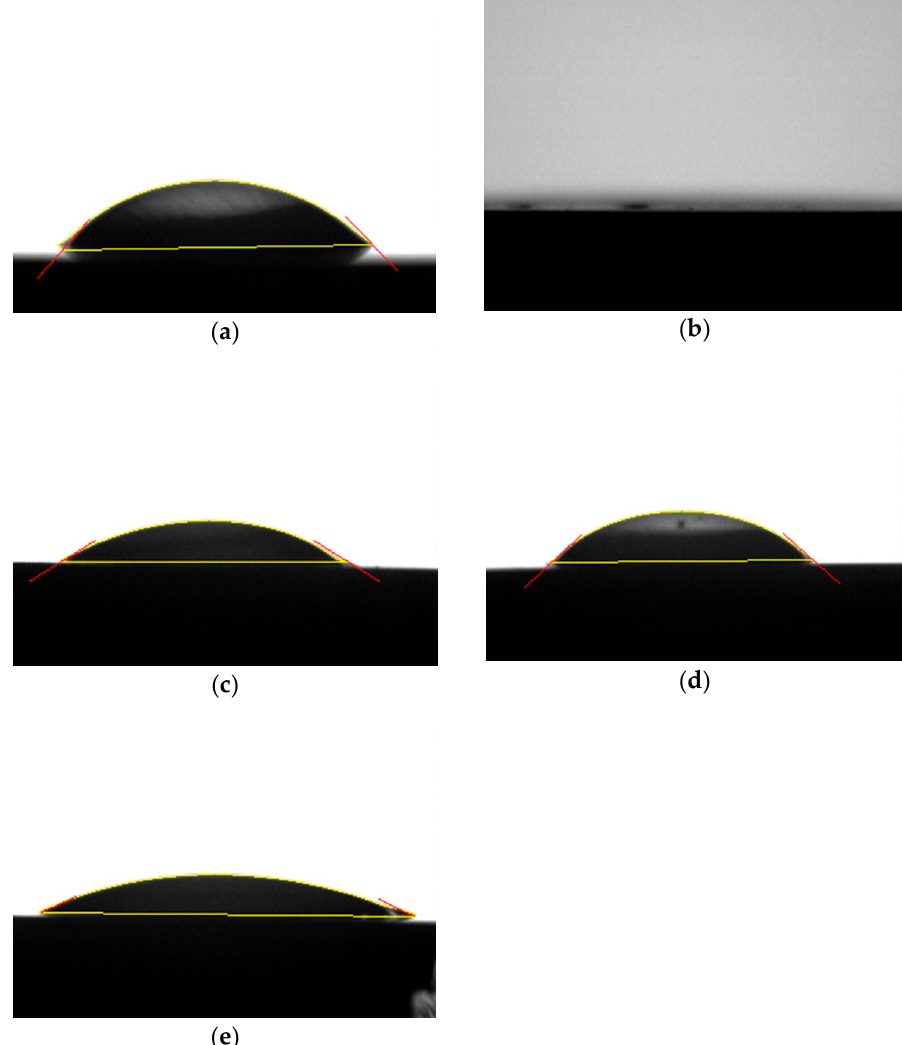
Figure 5. Apparent contact angle measurement of a drop of distilled water after plasma treatment. ( a ) Control (no treatment), ( b ) P0 group (immediately after treatment), ( c ) P1 group (24 h after treatment), ( d ) P2 group (48 h after treatment), ( e ) P3 group (72 h after treatment).